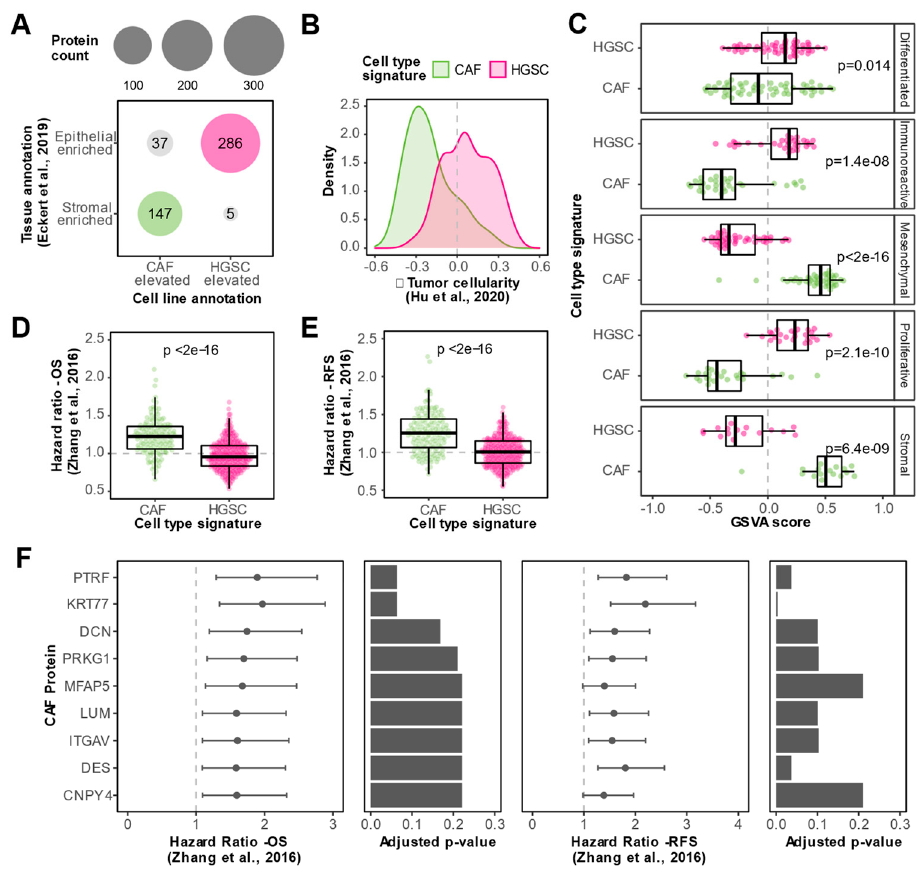
Figure 4. Identification of CAF proteins associated with clinical outcomes in HGSC. ( A ) Dot plot visualizing the integration between WCL cell line and tissue data [18] for the identification of cell type signatures. Proteins with cell line annotations that coincide with tissue annotations are colored and denoted as high-confidence CAF (green) or HGSC (magenta) proteins. Size of circles correspond to the number of proteins. ( B ) Density plot showing spearman correlations with tumor cellularity in Hu et al., 2020 dataset [19] for proteins in the CAF (green) or HGSC (magenta) signatures. ( C ) Box plots illustrating gene set variation analysis (GSVA) scores for high-confidence CAF (green) and HGSC (magenta) proteins in HGSC tumor proteomes, stratified by HGSC proteomic subtypes determined by Zhang et al. [20]. Dots indicate GSVA scores of individual HGSC tumor samples. p -values from a Student’s t -test between CAF and HGSC GSVA scores are reported. ( D ) Box plots comparing overall survival (OS) hazard ratios of proteins in CAF and HGSC signatures based on data from Zhang et al., [20]. Dots represent hazard ratios of individual proteins in each signature. p -value from a student’s t -test is reported. ( E ) Box plots comparing recurrence-free survival (RFS) hazard ratios of proteins in CAF and HGSC signatures based on data from the Zhang et al., 2016 dataset [20]. Dots represent hazard ratios of individual proteins in each signature. p -value from a student’s t -test is reported. ( F ) Hazard ratios (HR) and confidence intervals for nine CAF-enriched proteins that were statistically significantly associated with both poor overall survival and poor recurrence-free survival (FDR < 0.25 and HR > 1) in Zhang et al. 2016 cohort [20]. Bar plots show the Benjamini–Hochberg adjusted p -value from the log-rank test for the respective clinical